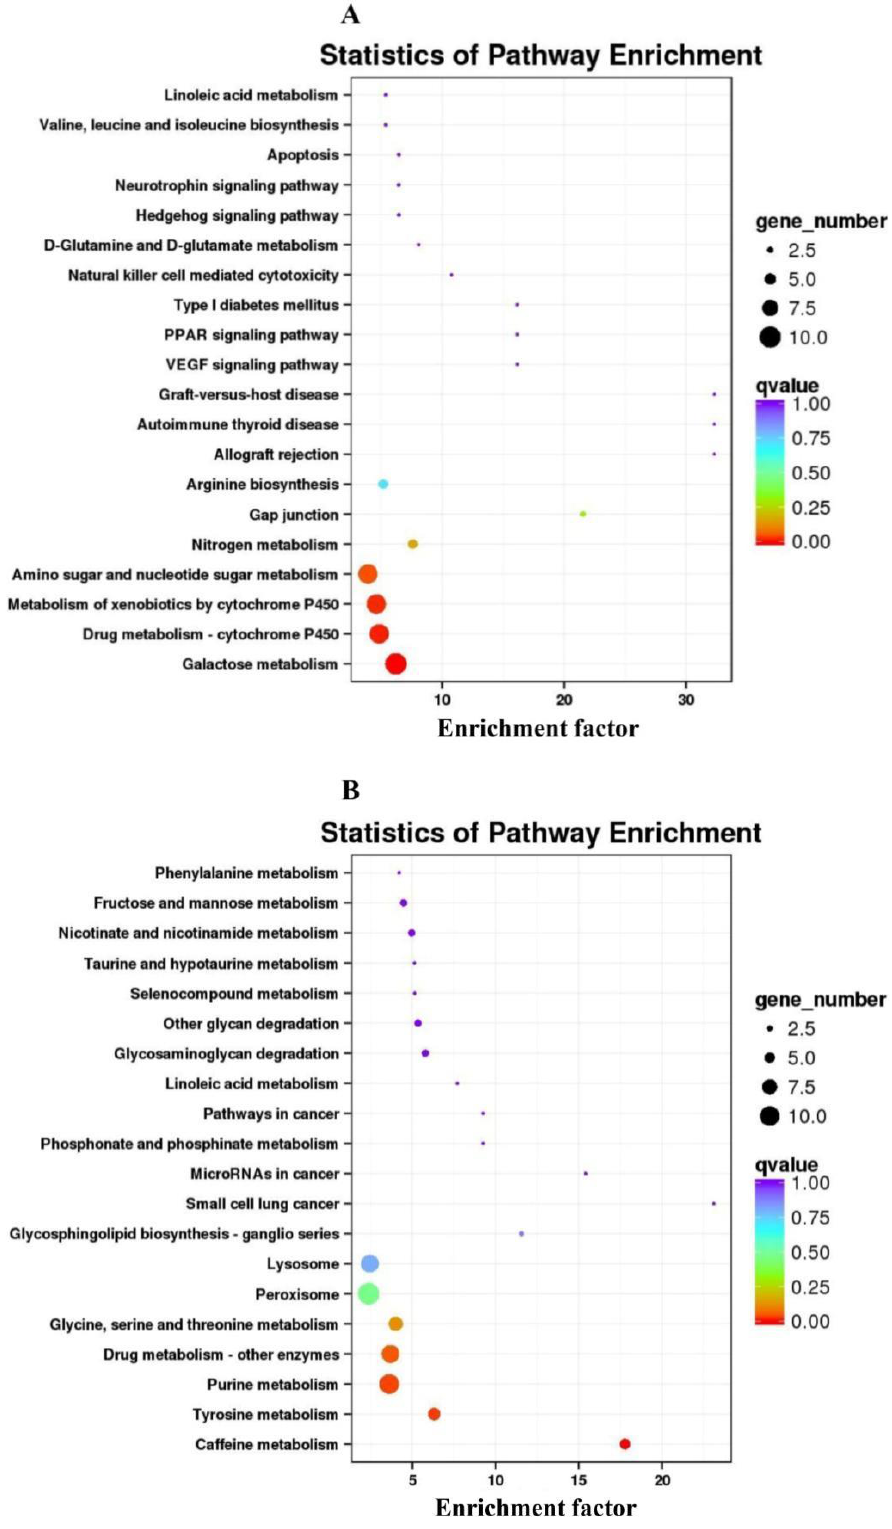
Figure 3. ( A ) KEGG significant enrichment analysis for the up-regulated genes. ( B ) KEGG significant enrichment analysis for the down-regulated genes. The significant enriched pathways were shown with their q-value (color), enrichment factor ( X -axis), and a number of involved differentially expressed genes (size of circles).